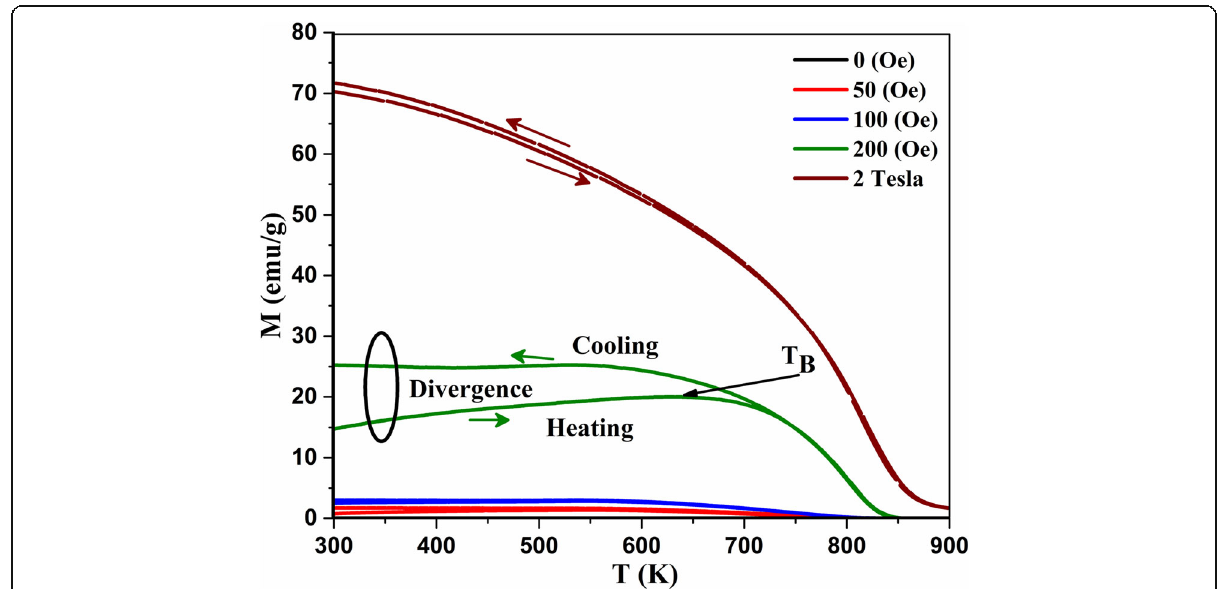
Fig. 7 Change of magnetization ( M ) with temperature for pristine Fe 3 O 4 nanoparticles at different external magnetic field ( H ). At H = 200 Oe, blocking temperature T B and magnetic divergence (labeled by circular ring) between the heating and cooling curves can be seen clearly